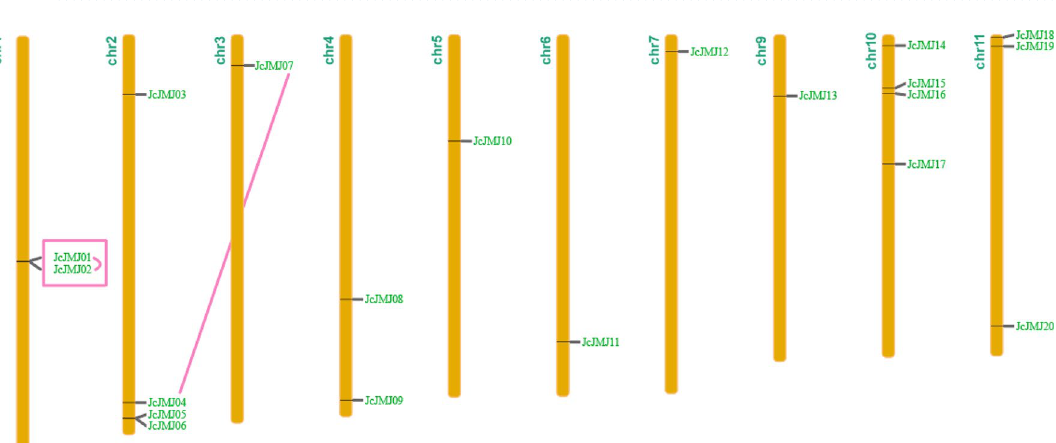
Figure 4. Chromosome locations and gene duplication events of JcJMJ genes in J. curcas . Gene names are on the right side of each chromosome according to the locations of JcJMJ genes. Segmentally duplicated genes are connected by pink line. Tandemly duplicated genes are connected by pink line and in the pink